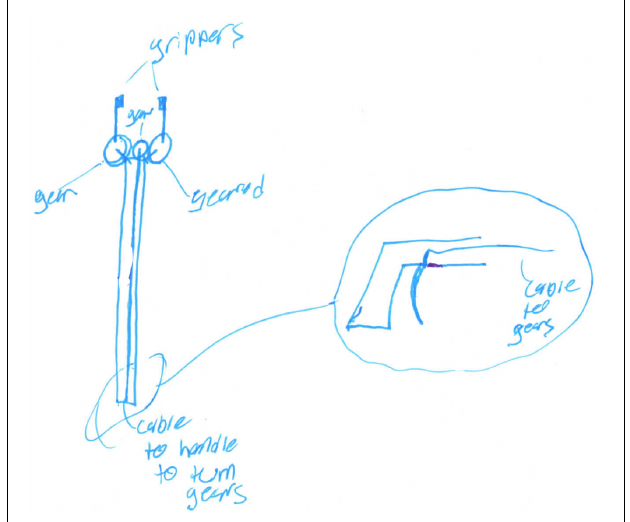
FIGURE 7 | A litter picker that received low originality and low novelty